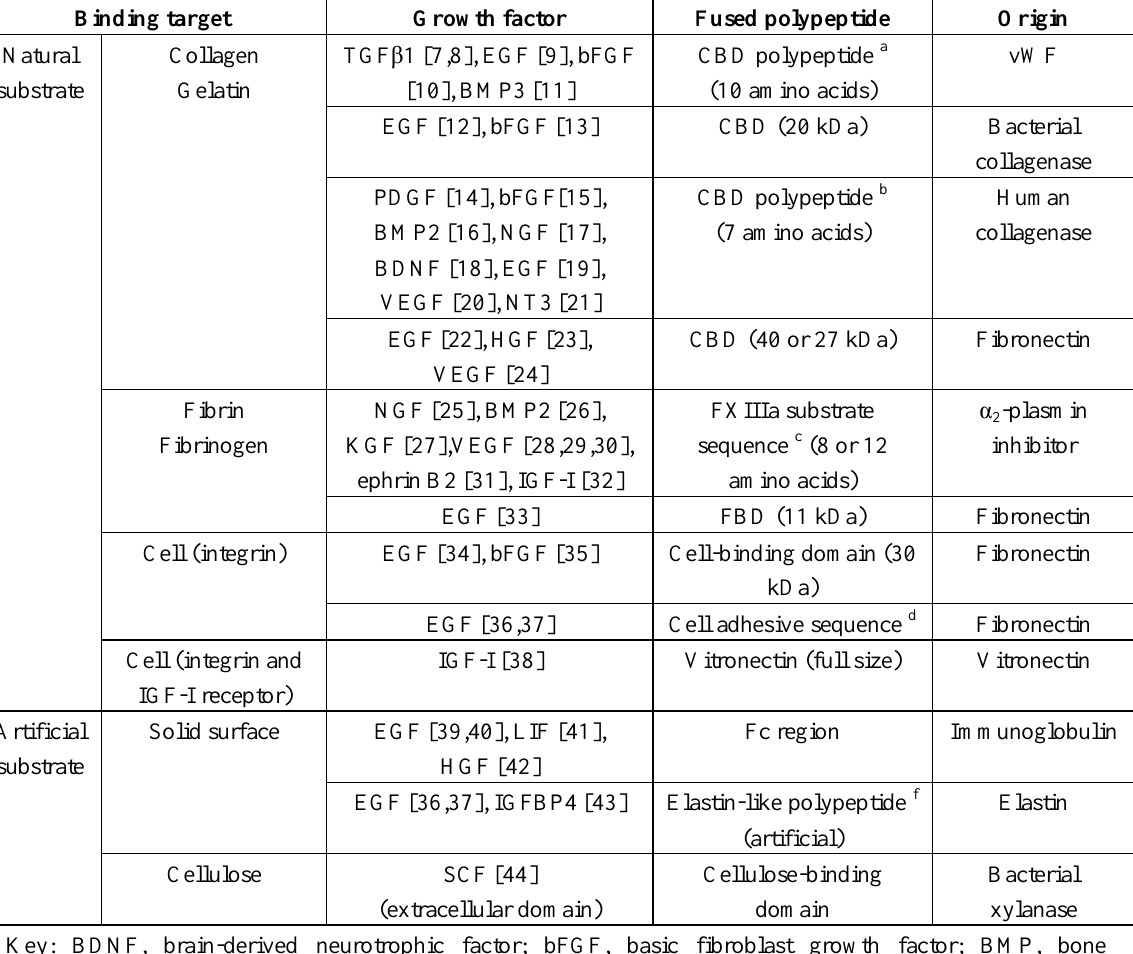
Table 1. Gene-engineered binding growth factors which bind to biological and organic